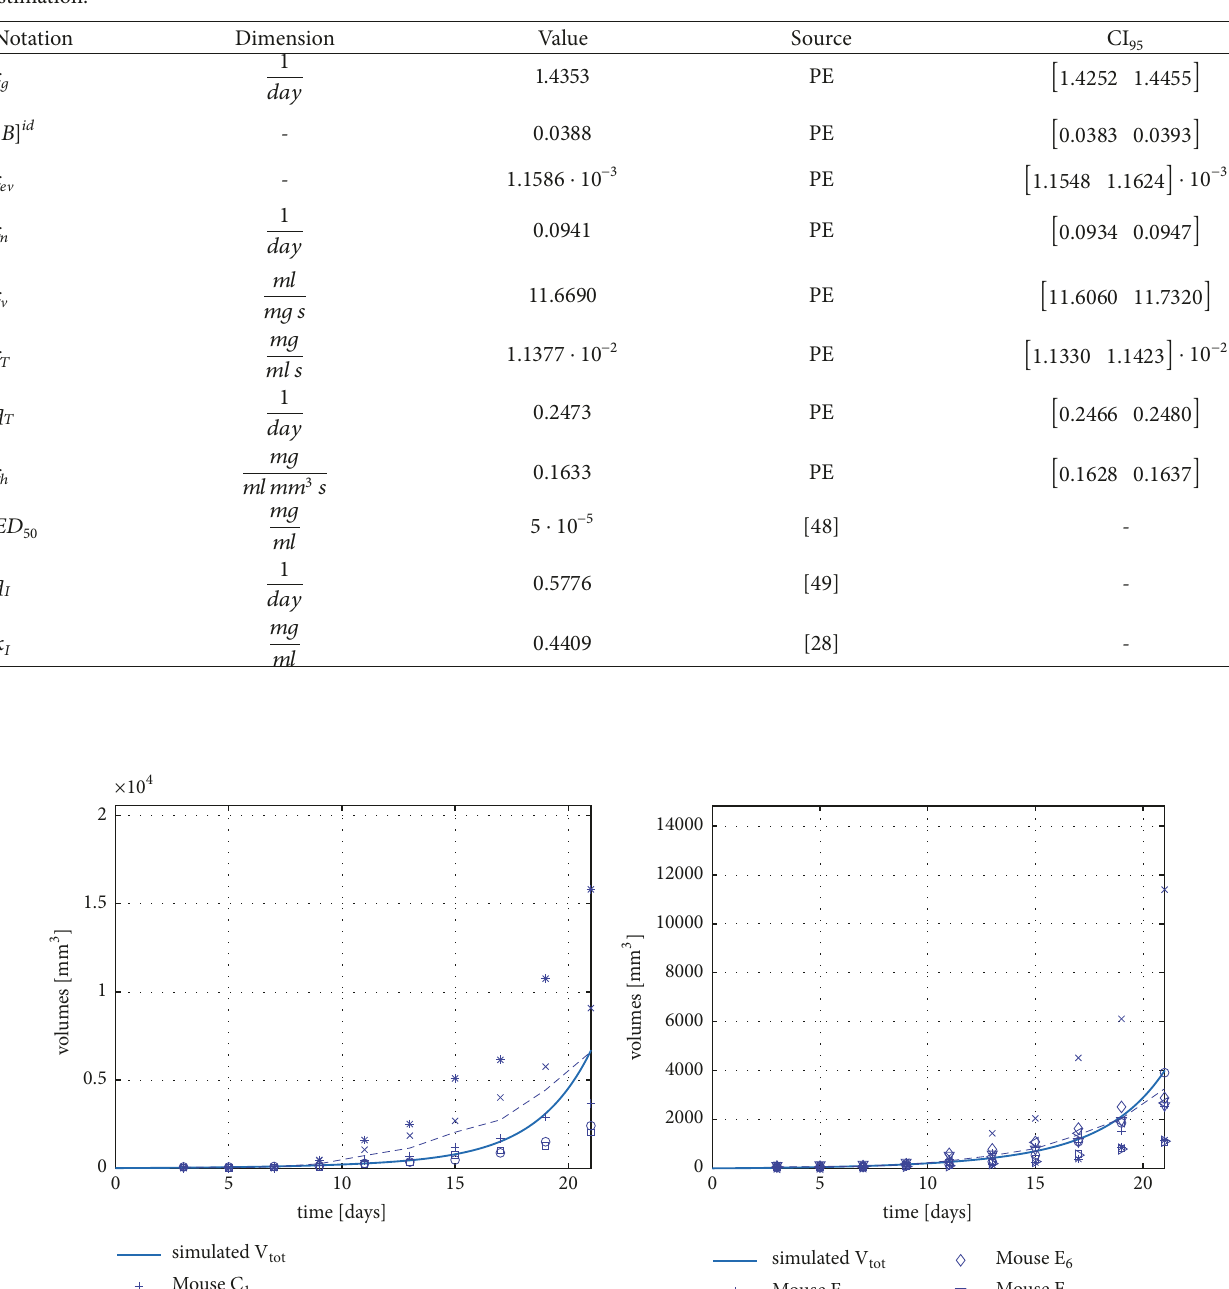
Table 2: Nominal model parameters ( 𝜃 𝑛𝑜𝑚 ) and their dimension, source, and 95% confidence interval (CI 95 ). PE stands for parameter estimation.